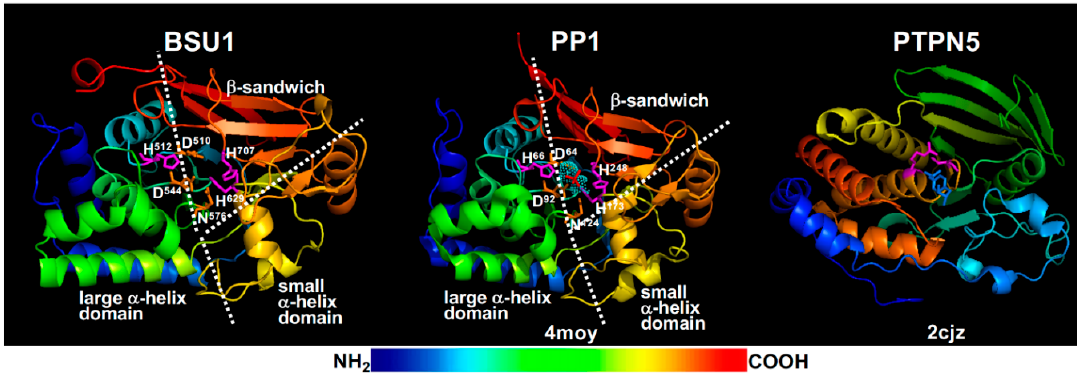
Figure 6. Comparison between a structure model of BSU1’s phosphatase domain with crystal structures of PSP (protein Ser / Thr phosphatase) and PTP (protein tyrosine phosphatase). Shown here are a predicted structure of the BSU1’s C-terminal phosphatase domain [obtained at SWISS-MODEL at https: // swissmodel.expasy.org / using the protein sequence of BSU1 (accession No: NP_171844)], a crystal structure of a human PSP (HsPP1; Protein Data Bank No. 4moy), and a crystal structure of a human PTP (HsPTPN5 for the human PTP non-receptor type 5; Protein Data Bank No. 2cjz). The conserved metal-coordinating amino acid residues are indicated by colored sticks: orange colored Asp(D) 510 , Asp(D) 544 , and Asn(N) 576 , and three magenta-colored His(H) residues. The three dotted white lines separate the β -sandwich of two β -sheets from the two flanking α -helix domains in the structure models of BSU1 and PP1. The dotted spheres and the red sticks in PP1 represent two metal ions and the phosphate, respectively. The two conserved residues (Cys and Arg of the HCX 5 R catalytic signature motif) are colored with magenta in the human PTPN5 structure and a phosphorylated tyrosine is shown with blue sticks. The rainbow bar indicates the order of AAs from the N-terminus (blue) to the C-terminus (red) of each